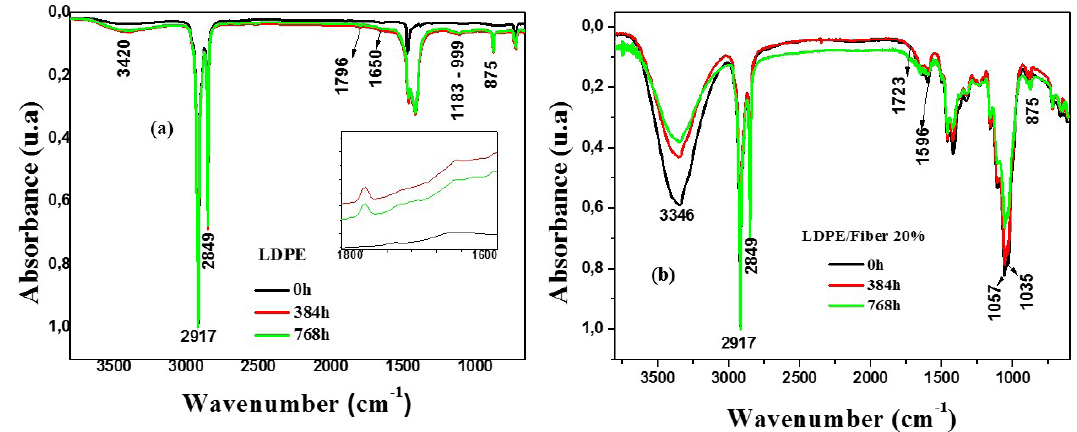
Figure 7. FTIR of pure LDPE matrix (a) different times of degradation in UV-B and (b) 20% fiber at different times of degradation UV-B.